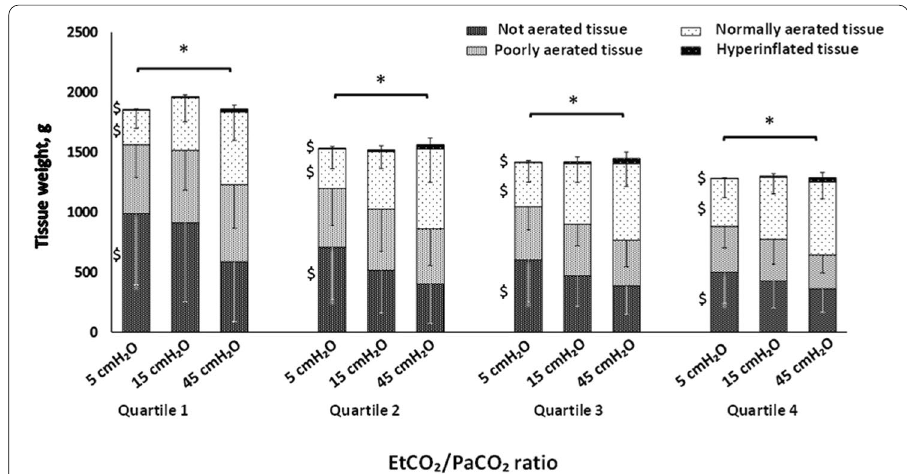
Fig. 3 Portions of lung tissue classified as not aerated, poorly aerated, normally aerated and hyperinflated among P ET CO 2 /PaCO 2 ratio quartiles to the response of step increase of PEEP at 5, 15 and 45 cmH 2 O. The asterisk denotes p < 0.001 among the portions of tissue throughout P ET CO 2 /PaCO 2 ratio quartiles for Mann–Whitney test. The dollar denotes p < 0.001 among portions of lung tissue to the response to PEEP for Wilcoxon test